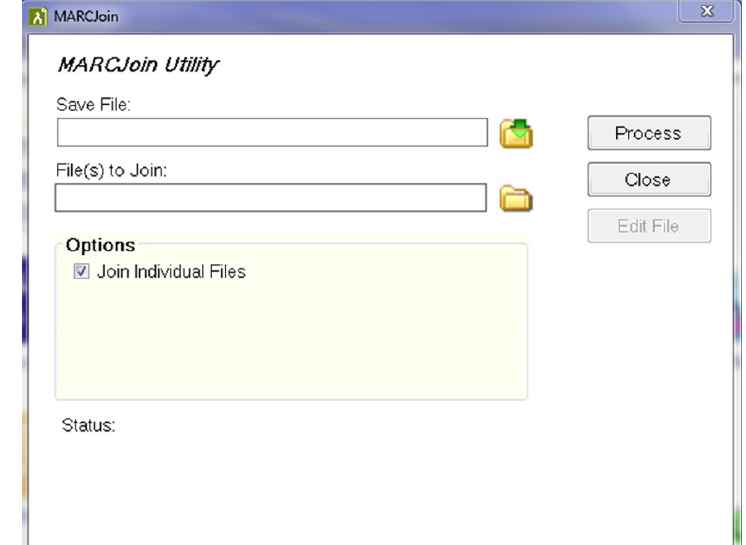
Figure 1 MARCJoin